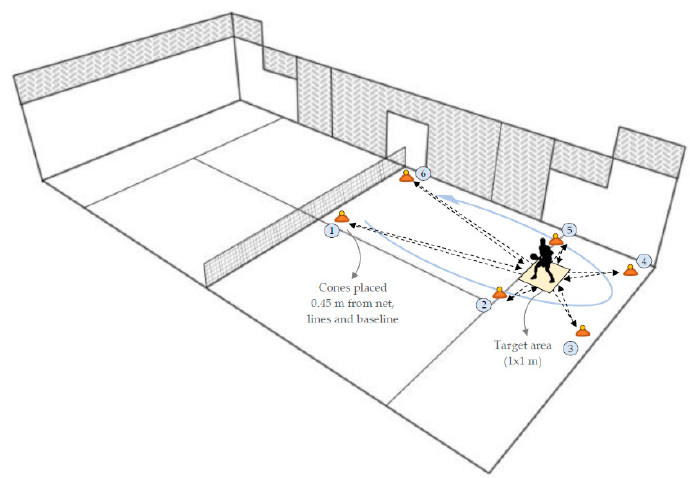
Figure 1. Specific padel agility test. Adapted from